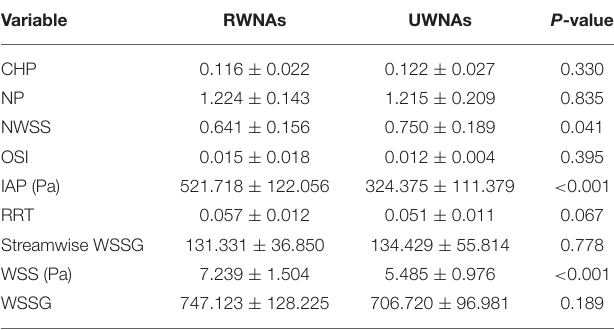
TABLE 4 | Results of hemodynamic parameters between RWNAs and UWNAs. Variable